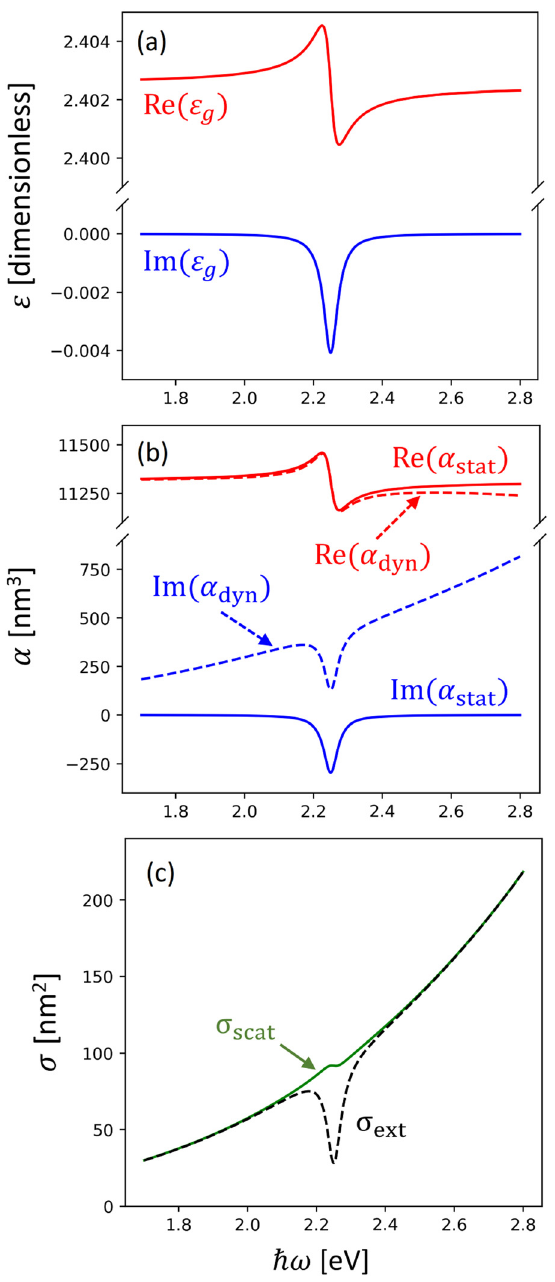
Figure 2: (a) Electric permittivity ε g of a gain medium with refractive = 0.025 eV, and peak gain index n g = 1.55, gain bandwidth ℏ γ g coef fi cient g max = 300 cm − 1 at ℏ ω g = 2.25 eV: real part – red, imaginary part – blue. (b) Scalar polarizabilities α of a gain medium nanoparticle of radius ρ = 80 nm embedded in a dielectric environment of refractive index n d = 1.5: static polarizability – solid lines, dynamic polarizability – dashed lines, real part – red, imaginary part – blue. (c) Optical cross sections σ of the same nanoparticle:scatteringcrosssection – solidgreen,extinctioncross section – dashed